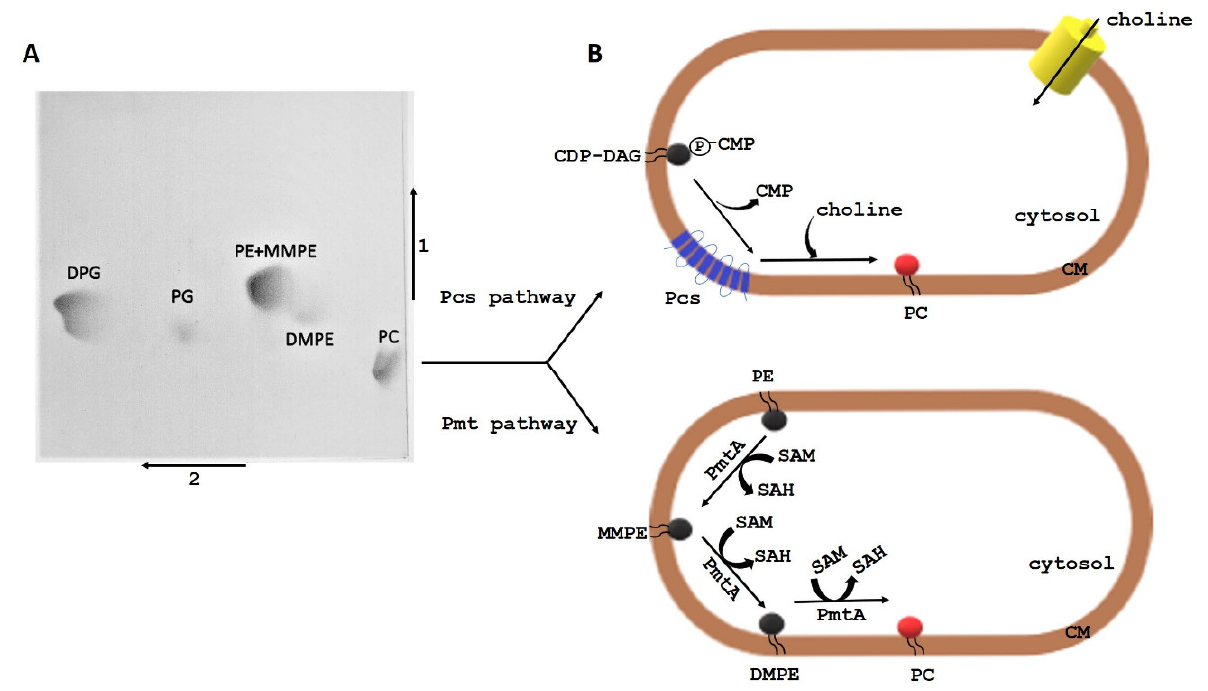
Figure 2. ( A ) Two-dimensional thin-layer chromatogram of phospholipids from Legionella gormanii . PC— phosphatidylcholine, DMPE—phosphatidyl- N , N -dimethylethanolamine, PE—phosphatidylethanolamine, MMPE— phosphatidyl- N -monomethylethanolamine, PG—phosphatidylglycerol, and DPG—diphosphatidylglycerol (cardiolipin). Solvent system: (1) first dimension—chloroform/methanol/water (14:6:1, v / v / v ) and (2) second dimension— chloroform/methanol/glacial acetic acid (13:5:2, v / v / v ). ( B ) PC biosynthesis pathways in L. pneumophila . CDP, diacylglycerol; Pcs, phosphatidylcholine synthase; PmtA, phospholipid N -methyltransferase; SAM, S -adenosylmethionine; SAH, S -adenosylhomocysteine; and CM, cytoplasmic membrane.